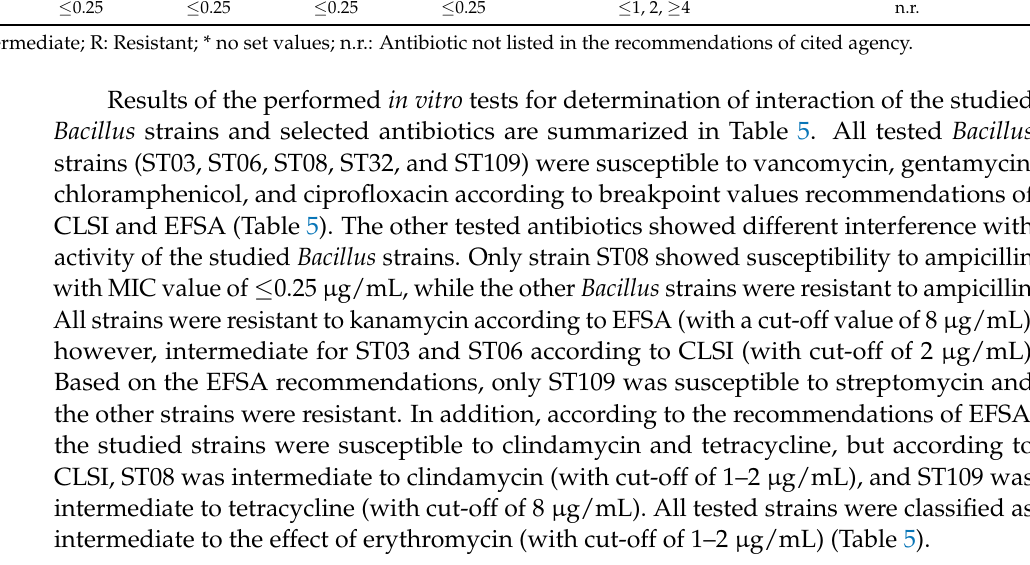
(Table 2). Based on the in vitro test with vancomycin, all tested Bacillus strain were sus- ceptible with cut-off values of 0.5 µ g/mL, suggesting their susceptibility according to the